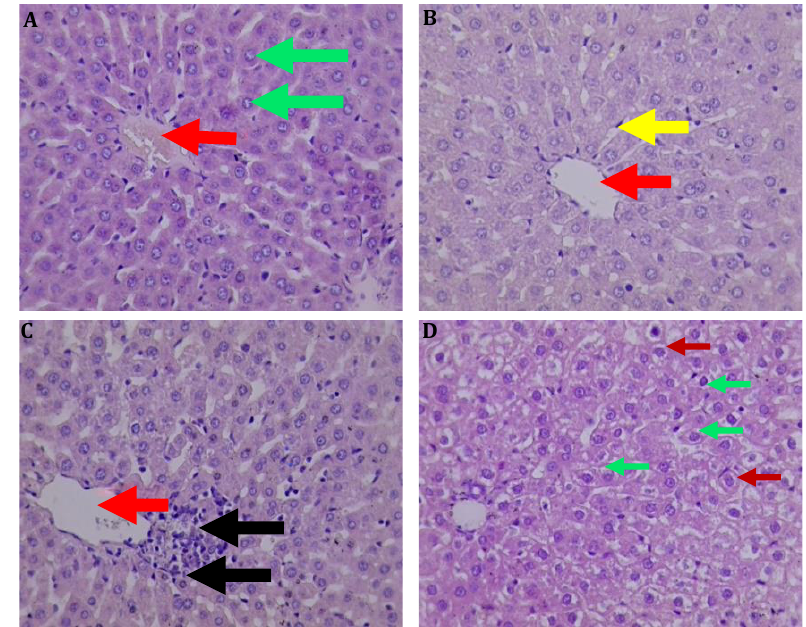
Figure 5. Representative histology images of liver from ( A ) control rats showing no-clear pathological lesion appears in the structure of the liver with normal congestion of blood vessels and normal hepatocyte, ( B ) rats orally given 200 mg/kg BW sodium butyrate showing normal hepatocyte without pathological changes, ( C ) rats orally given 50 mg/kg BW lead acetate showing pre-vascular mild filtration of the nuclear cell (macrophage) and lymphocyte, ( D ) rats orally given both sodium butyrate (200 mg/kg BW) and lead acetate (50 mg/kg BW) showing cellular swelling with loss of sinusoid. H&E,